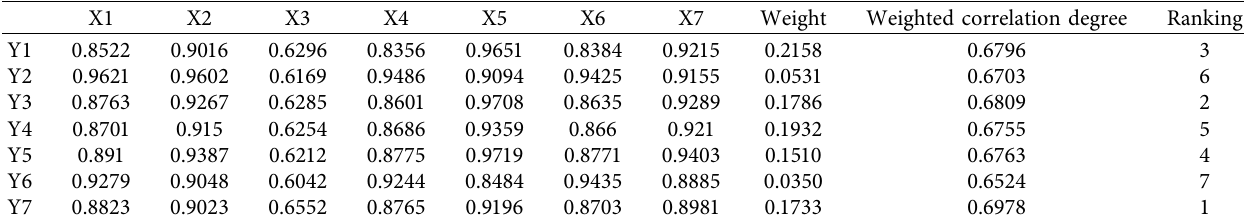
Table 7: Weighted-grey correlation degrees of logistics indices to economic system.